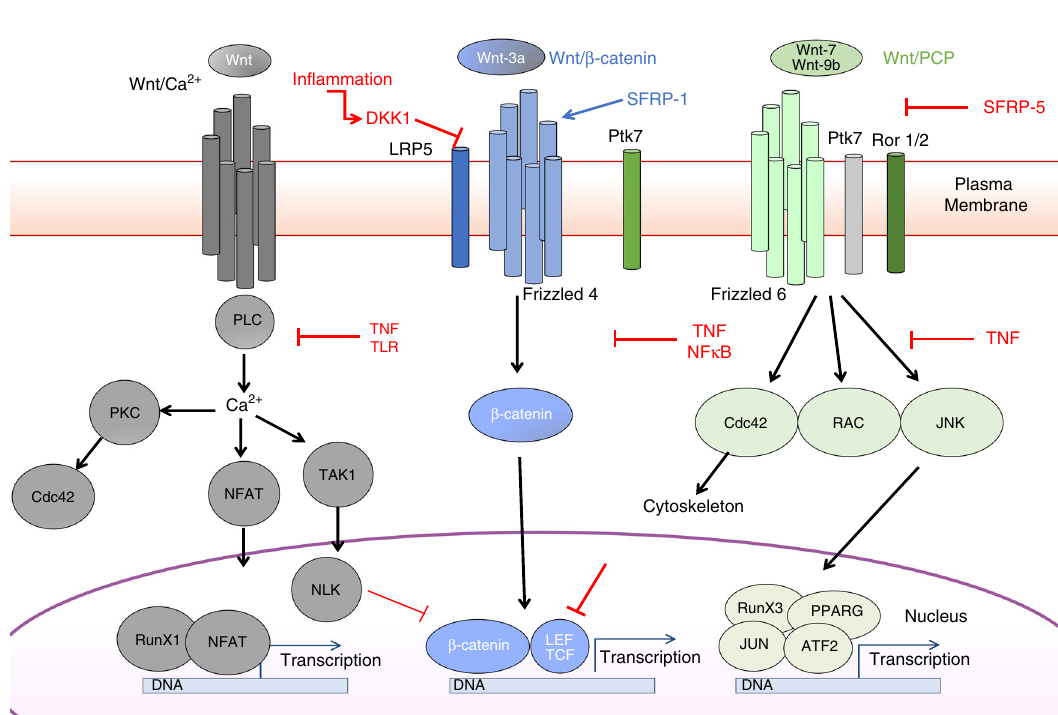
Fig. 7 Wnt Signaling pathway in CD4 T SCM during aging and in fl ammation. Graphical summary of key molecules involved in the speci fi c signature of individual T SCM cluster identi fi ed by scRNAseq gene expression analysis. Gray, blue, and green boxes represented highlighted molecules in Wnt/calcium, Wnt/ β -catenin, and Wnt/PCP, respectively. Red arrows and characters summarized the alterations of Wnt signaling observed in aged donors and/or chronic in fl ammation described in this